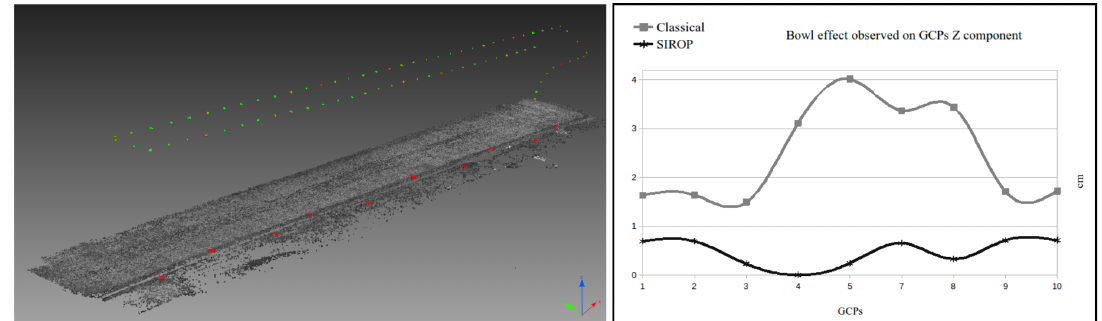
Figure 27. The non-linear distortion effect correction on Corridor dataset. ( Left ): Linear acquisition protocol and GCPs distribution (red point). ( Right ): comparison of 3D uncertainty on Z shows the dome effect with classical processing, and the correction obtained by SIROP .